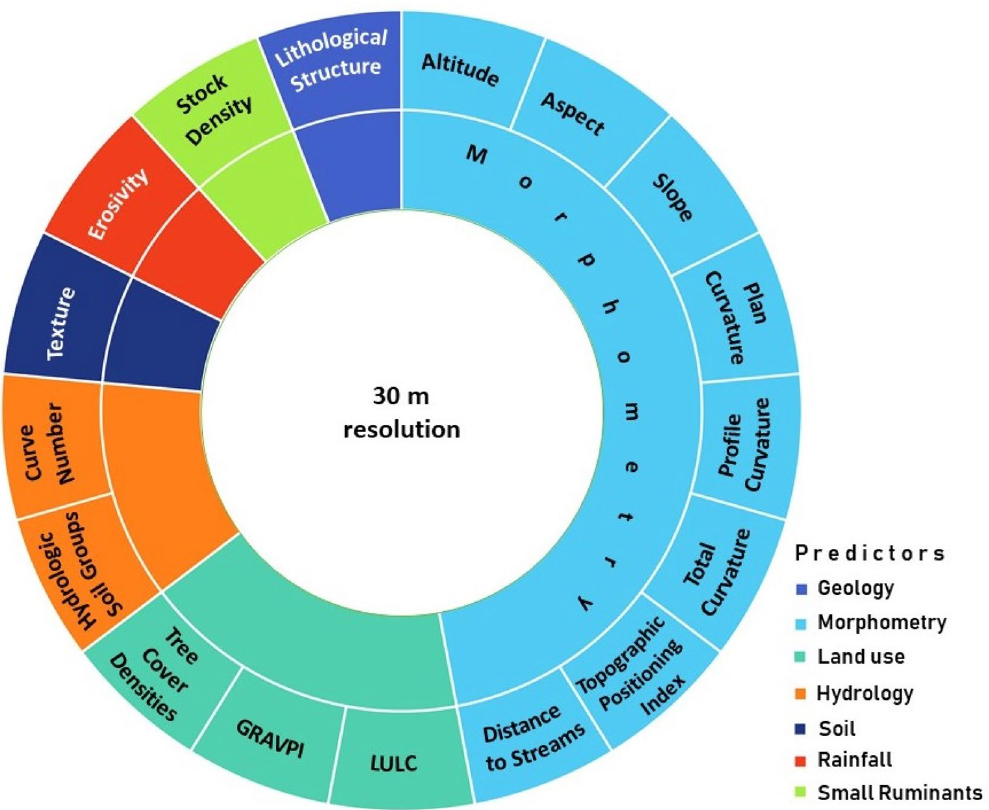
Figure 2. The proposed hierarchy predictors and their geographical use to develop the Grazing Susceptibility to Land Degradation Index. (GRAVIPA = Grassland Vegetation Probability Index; LULC = Land Use Land Cover). The figure was shaped by G. Minea using Microsoft 365 PowerPoint (https:// www. micro soft. com/ en- us/ micro soft- 365/ power